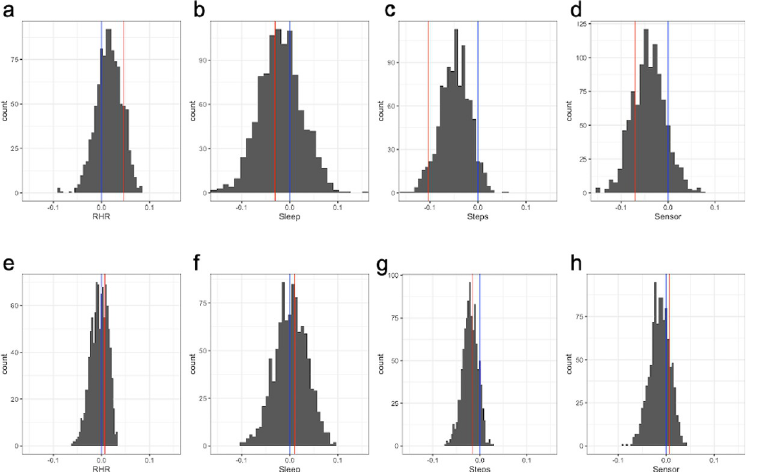
Fig 3. One-sided conditional permutation test for assessing the null that, compared to random data reduction, no additional change in AUC caused by removing data. ( a-d ) on or after receipt of test result and ( e-h ) in the symptomatic period and prior to receipt of test results. The random data removal and AUC calculation are done for RHR, sleep, step and the all sensor data, respectively (shown in four panels in each row). In each panel, the red line indicates the observed change of AUC; the blue line is at zero, indicating no change. The reference distributions are not centered at zero despite data removal being random; because on average there are more days after the receipt of test results than before, random data removal may still impact AUCs. For each metric, if a red line is at the left tail of the histogram, we conclude a statistically significant additional decrease in AUC.